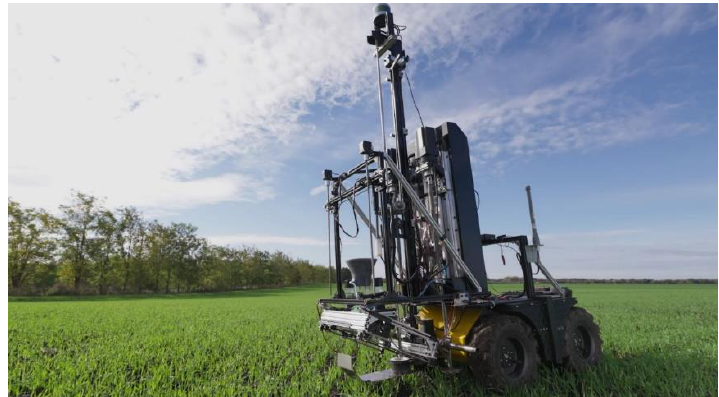
Figure 1. An autonomous robotic system—agrobot Lala.